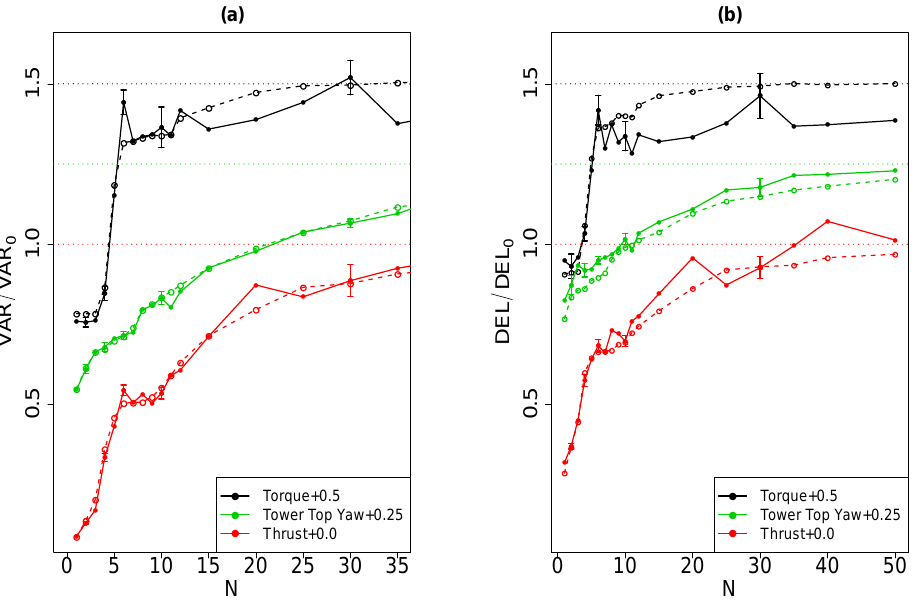
Torque+0.5 Tower Top Yaw+0.25 Thrust+0.0